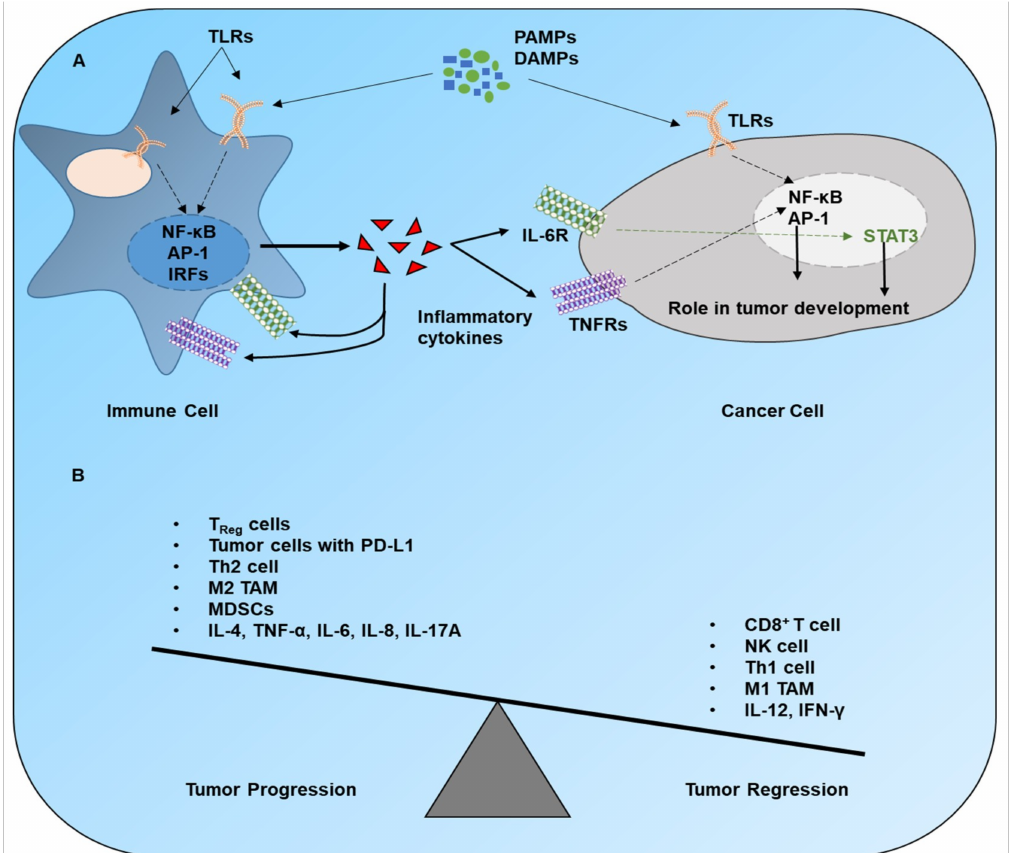
Figure 2. Immune regulation of cancer progression. ( A ) The stimulation of TLRs and other PRRs in immune cells launches downstream signaling pathways, which cause a release of various cytokines. These cytokines interact with their receptors on immune cells and cancer cells to trigger associated signaling pathways. The product(s) of these cascades plays a substantial role in the progression of cancer. ( B ) The overall outcome of cancer in a tumor microenvironment depends upon the ratio of protumor to antitumor signals. Legend: CD, cluster of di ff erentiation; DAMPs, damage-associated molecular patterns; IFN, interferon; IL, interleukin; MDSCs, myeloid-derived suppressor cells; NK, natural killer; PAMPs, pathogen-associated molecular patterns; PD-L1, programmed-death ligand 1; TAM, tumor-associated macrophage; Th2, T helper type 2; TNF- α , tumor necrosis factor α ; Treg, T